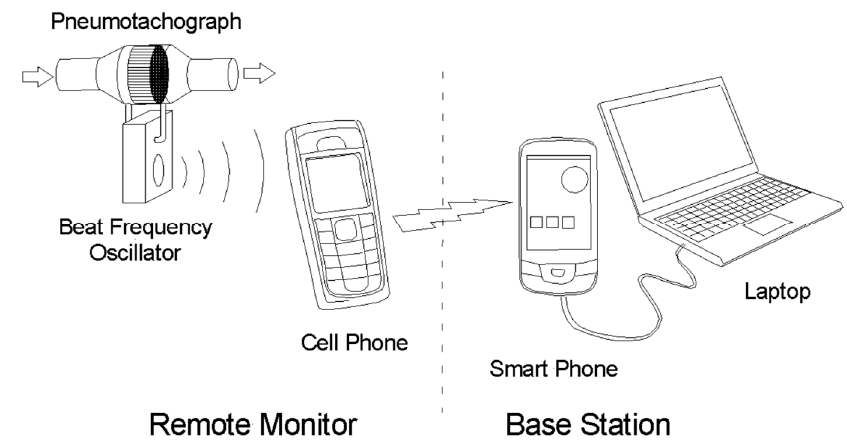
Figure 17. Complete telespirometer configuration.